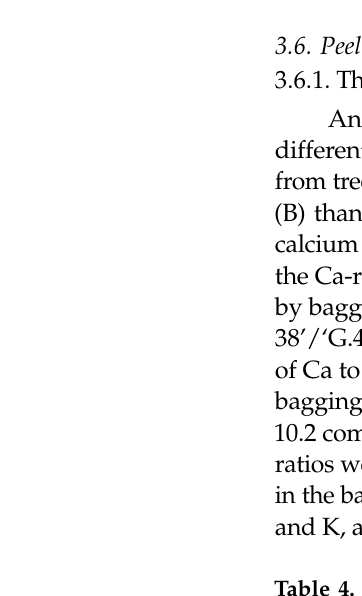
Table 4. ‘WA 38’ fruit mineral composition in 2020: comparison between T1-bagged (bag) and asymptomatic control (control GS-) apples within each rootstock (‘G.41’ and ‘M.9’), and direct comparison of element composition between asymptomatic fruit (GS-) from both rootstocks. Different capital letters (comparison between bagged and control GS- apples within each rootstock) and lowercase letters (comparison between control GS- apples across rootstock combinations; p = 0.05) indicate statistical differences and means separations by SNK. Significance by treatment combination within each rootstock: * = p ≤ 0.05, ** = p ≤ 0.01, ns = not